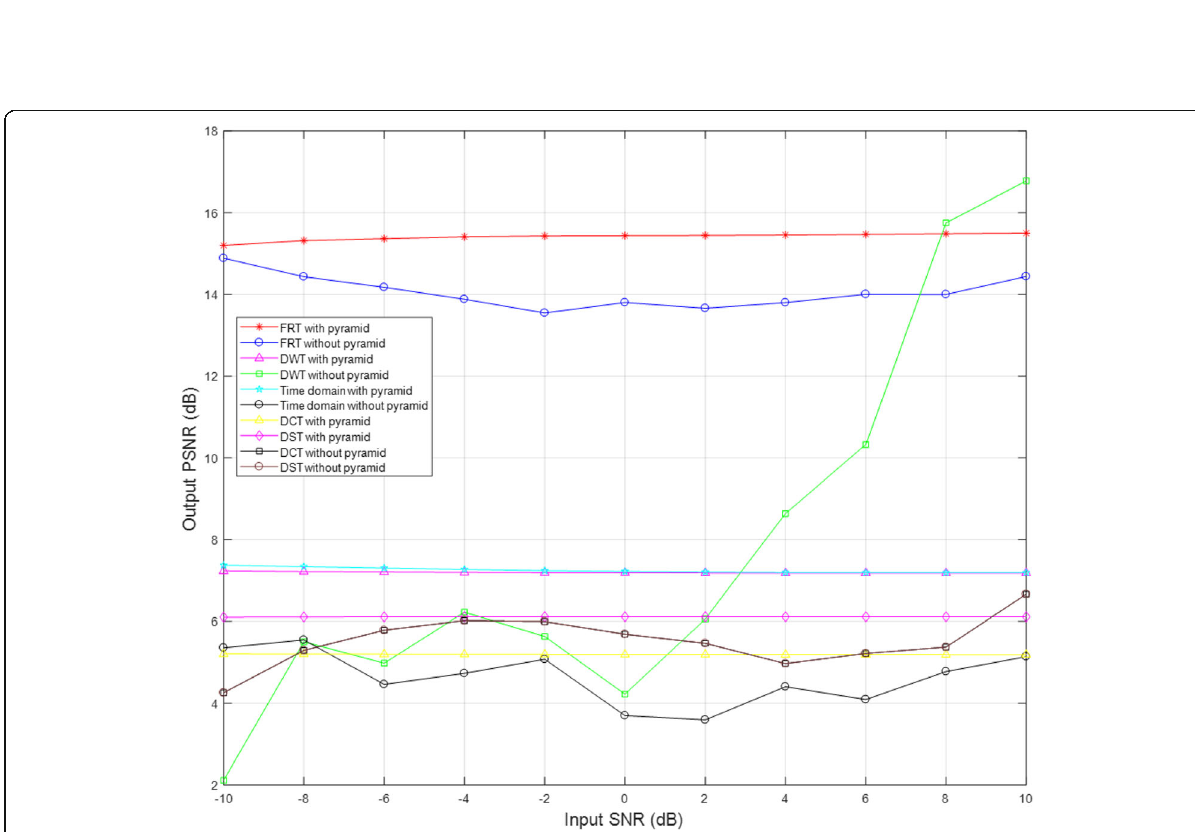
Fig. 14 Output PSNR vs. input SNR for Baboon image overall separation